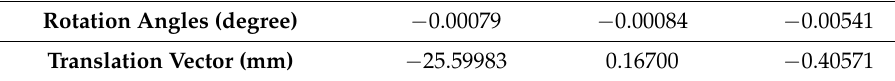
Table 2. External parameters of depth camera and RGB